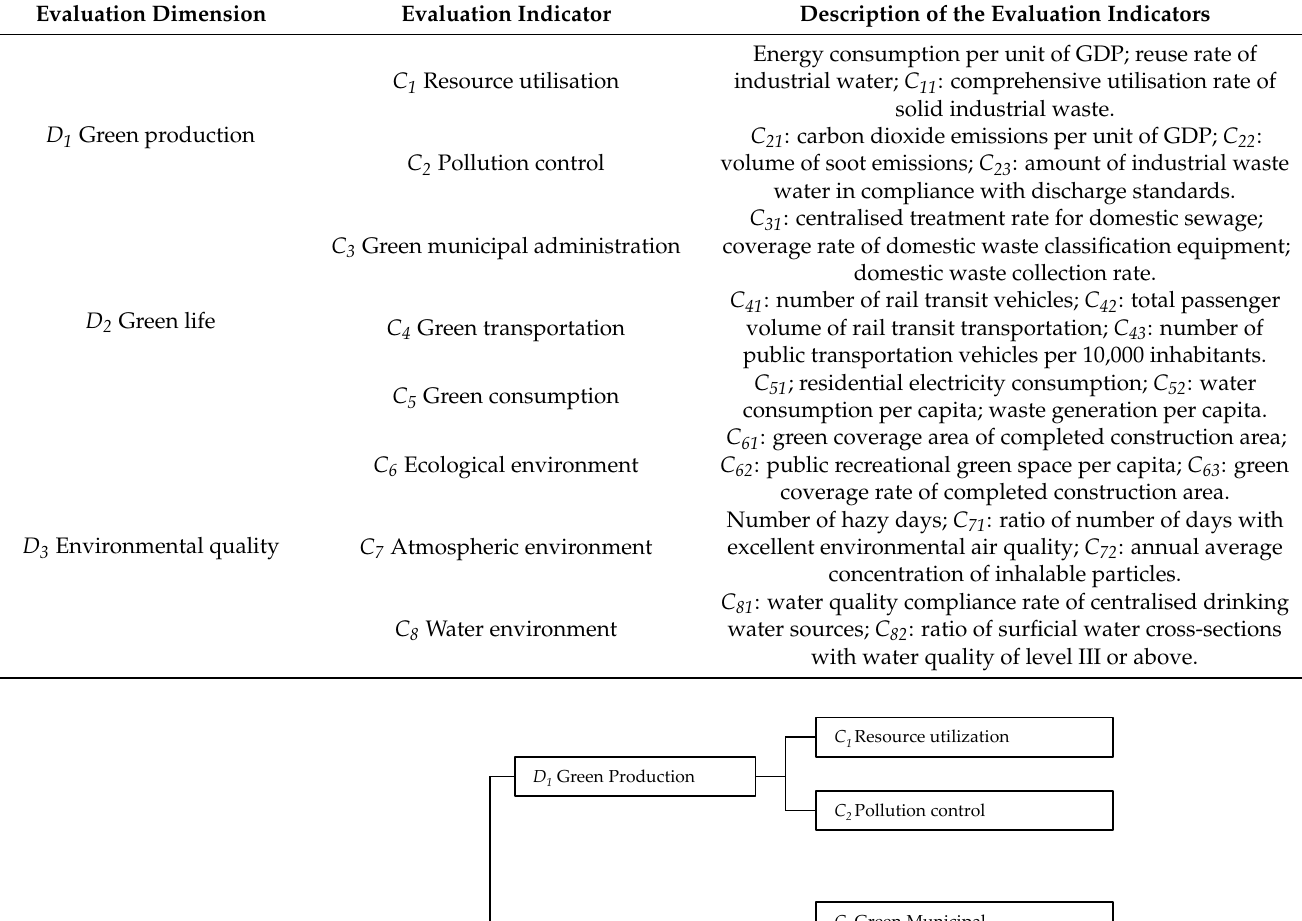
Table 3. Evaluation indicators for the level of sustainable development of a green city.